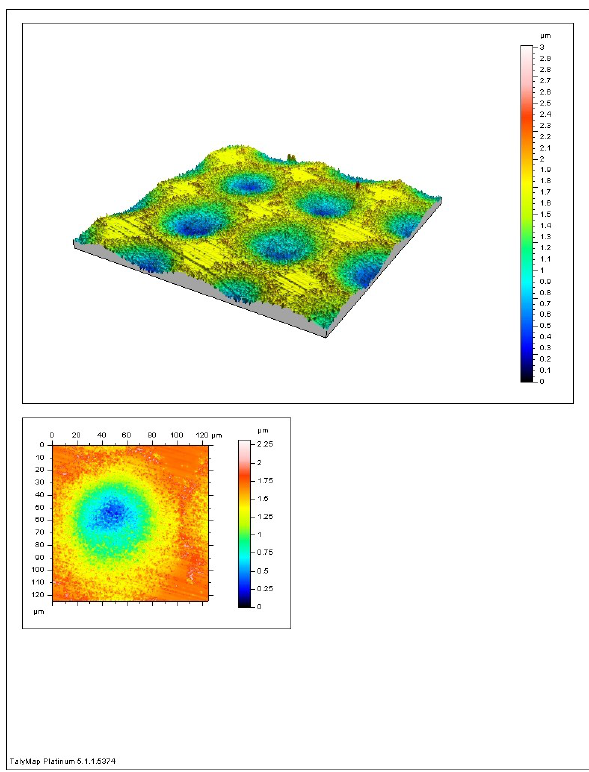
Figure 1: Isometric view of sample obtained with parameters: power 4W, frequency 133,33kHz, fluency 3,7 J/cm 2